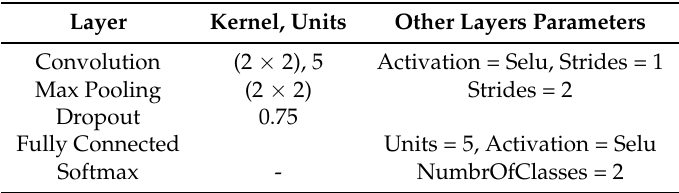
Table 2. Parameters used for all the layers of the proposed CNN model.